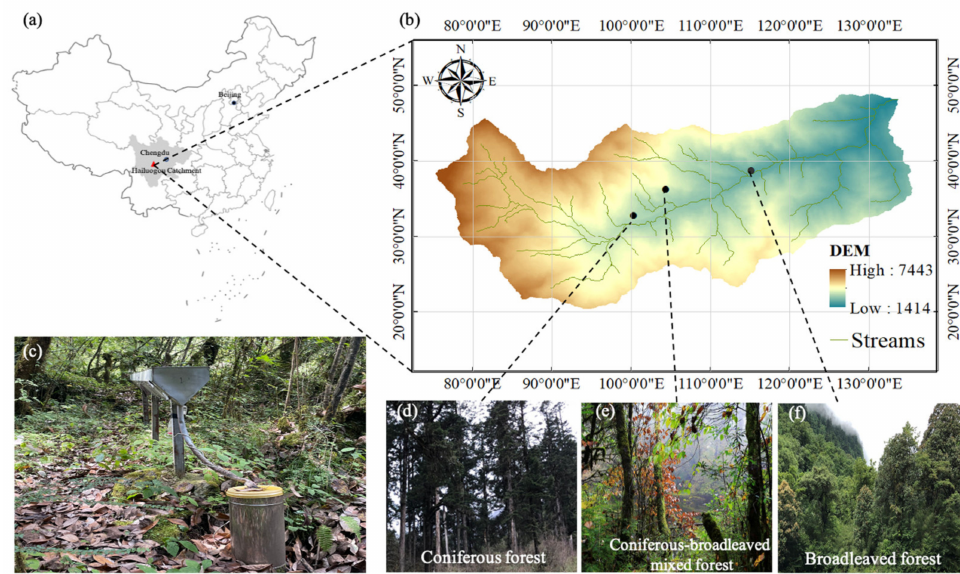
Figure 1. ( a ) The location of study site (from ULR http://bzdt.ch.mnr.gov.cn/, accessed on 15 April 2022). ( b ) An overview of the Hailuogou catchment showing the elevation gradient and the locations of the monitoring sites of broadleaved forests (BF), broadleaved-coniferous mixed forests (MF), and coniferous forests (CF). ( c ) The collector is composed of a V-shaped inclined metal trench connected to a tipping bucket rain gauge. ( d – f ) shows the stands in the three vegetation zones.